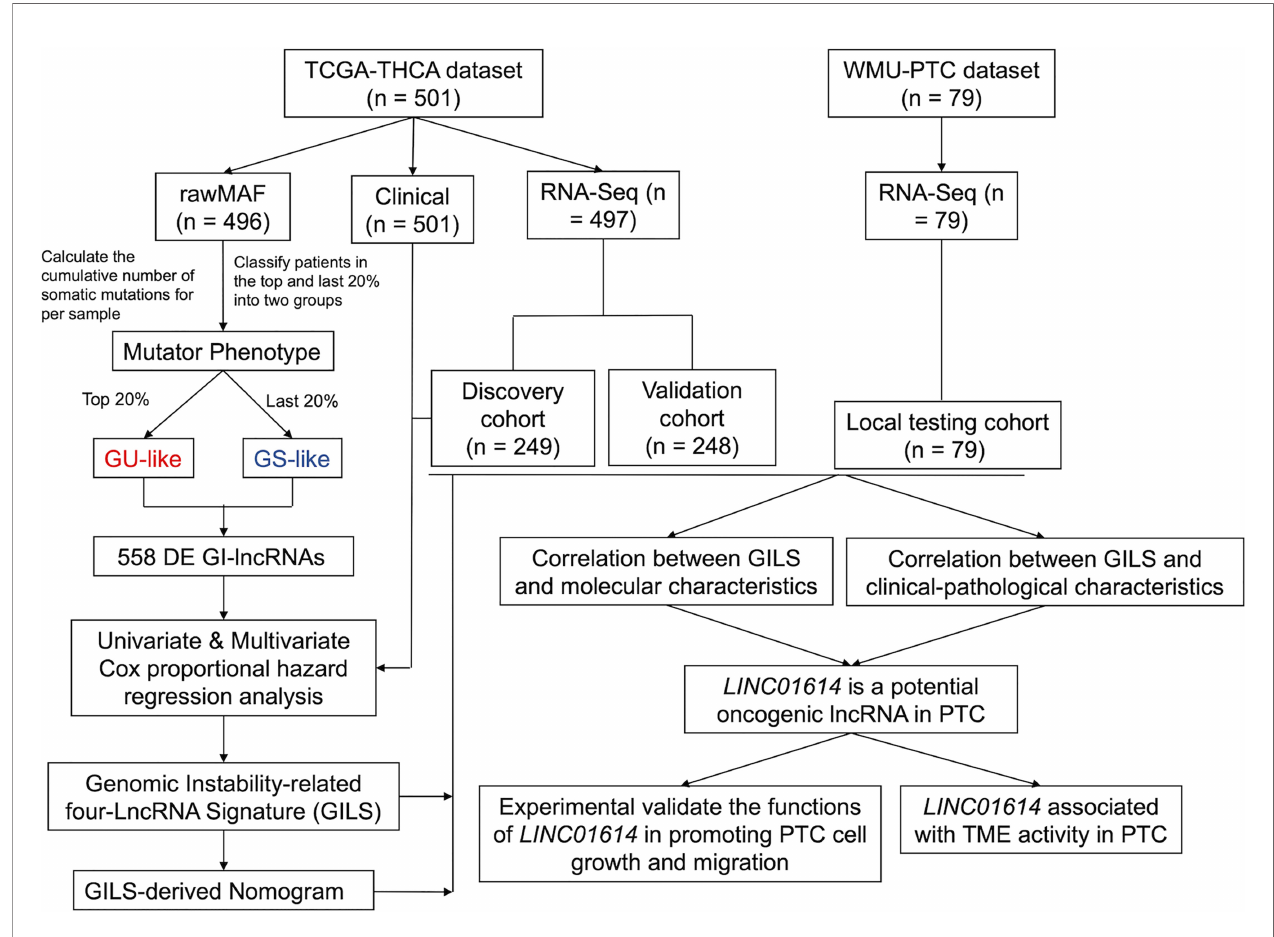
FIGURE 1 | Flowchart of the present